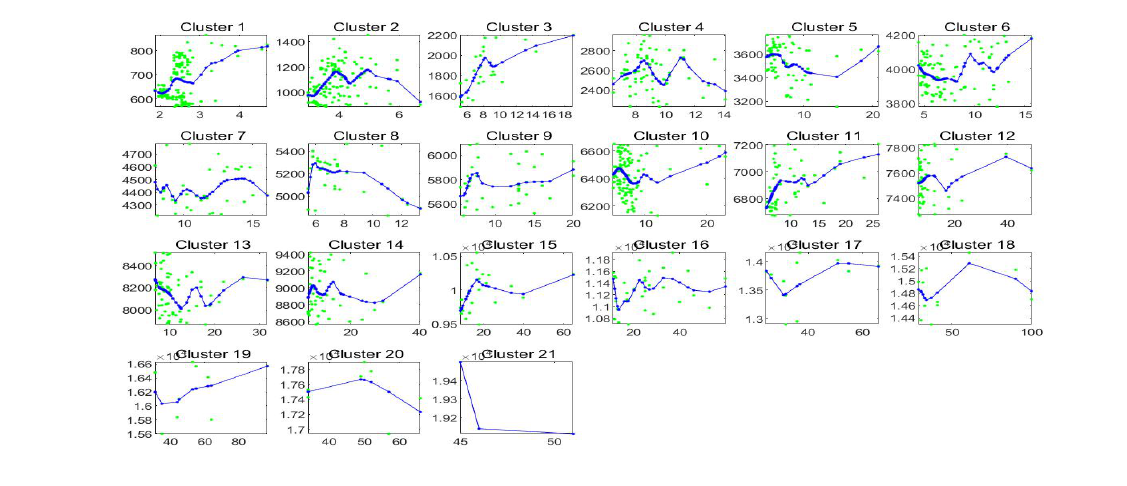
Figure 11. Clustering B: the fitted BitCoin time series is in blue colour; the observed BitCoin t values are